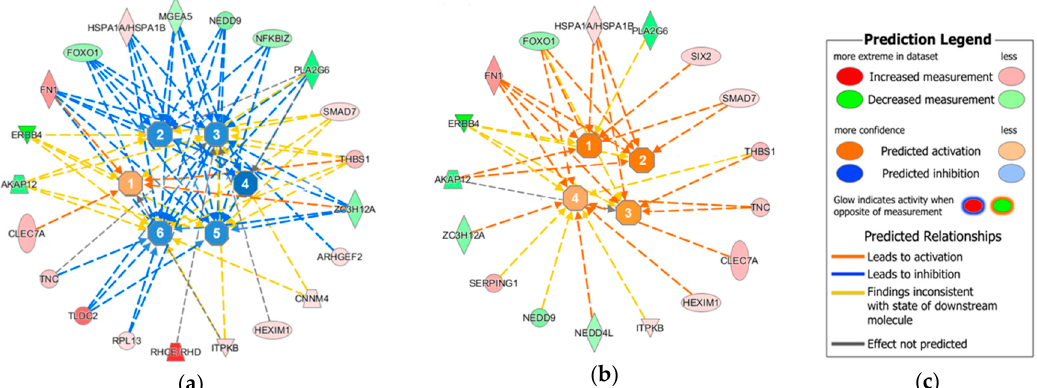
Figure 2. Core analyses network predictions for HBoV-infected CuFi-8 cells. This analysis shows that the 54 HBoV-specific genes are involved in apoptosis, necrosis and (re-)organization of the extracellular matrix. ( a ) Interaction of the different genes with phosphorylation processes (1), apoptosis (2), cell death in general (3) and of pancreatic cancer cells (4) and tumor cell lines (5) in particular, as well as necrosis (6). ( b ) Influence of the HBoV-specific genes on the organization of connective tissues, including growth (1), proliferation (2) amongst others of fibroblasts (3), and the quantity of cells (4). ( c ) Prediction legend. Orange indicates an upregulation, and blue represents a downregulation of the respective pathway. Grey indicates that no pathway alterations based on single transcripts could be predicted. Brighter color indicates a weaker alteration, whereas darker color indicates a strong regulation.